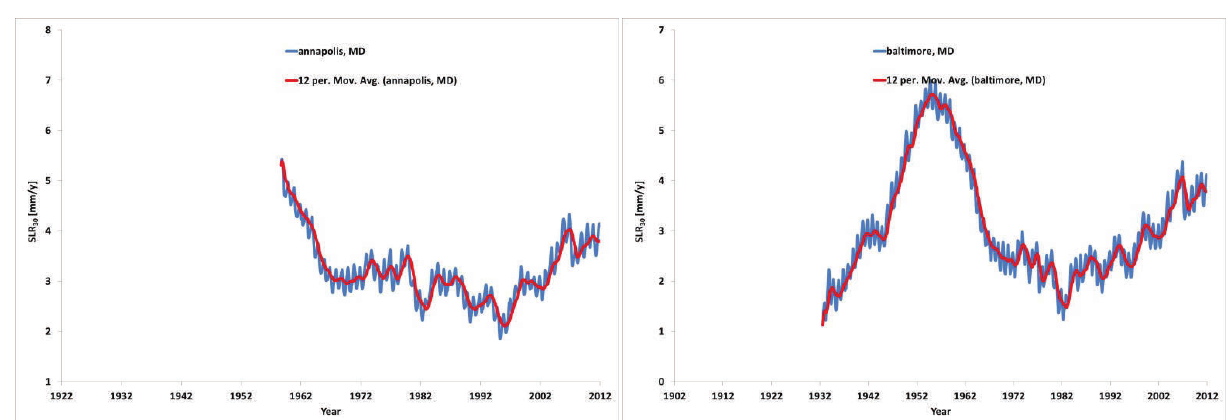
Figure 4. SLR 30 trend for the 6 stations in Maryland, Virginia and District of Columbia with more than 65 years of recording at the present time. These values oscillate because of the quasi-60 years oscillation and are not representative of any long term trend. (data from [12]; pictures from